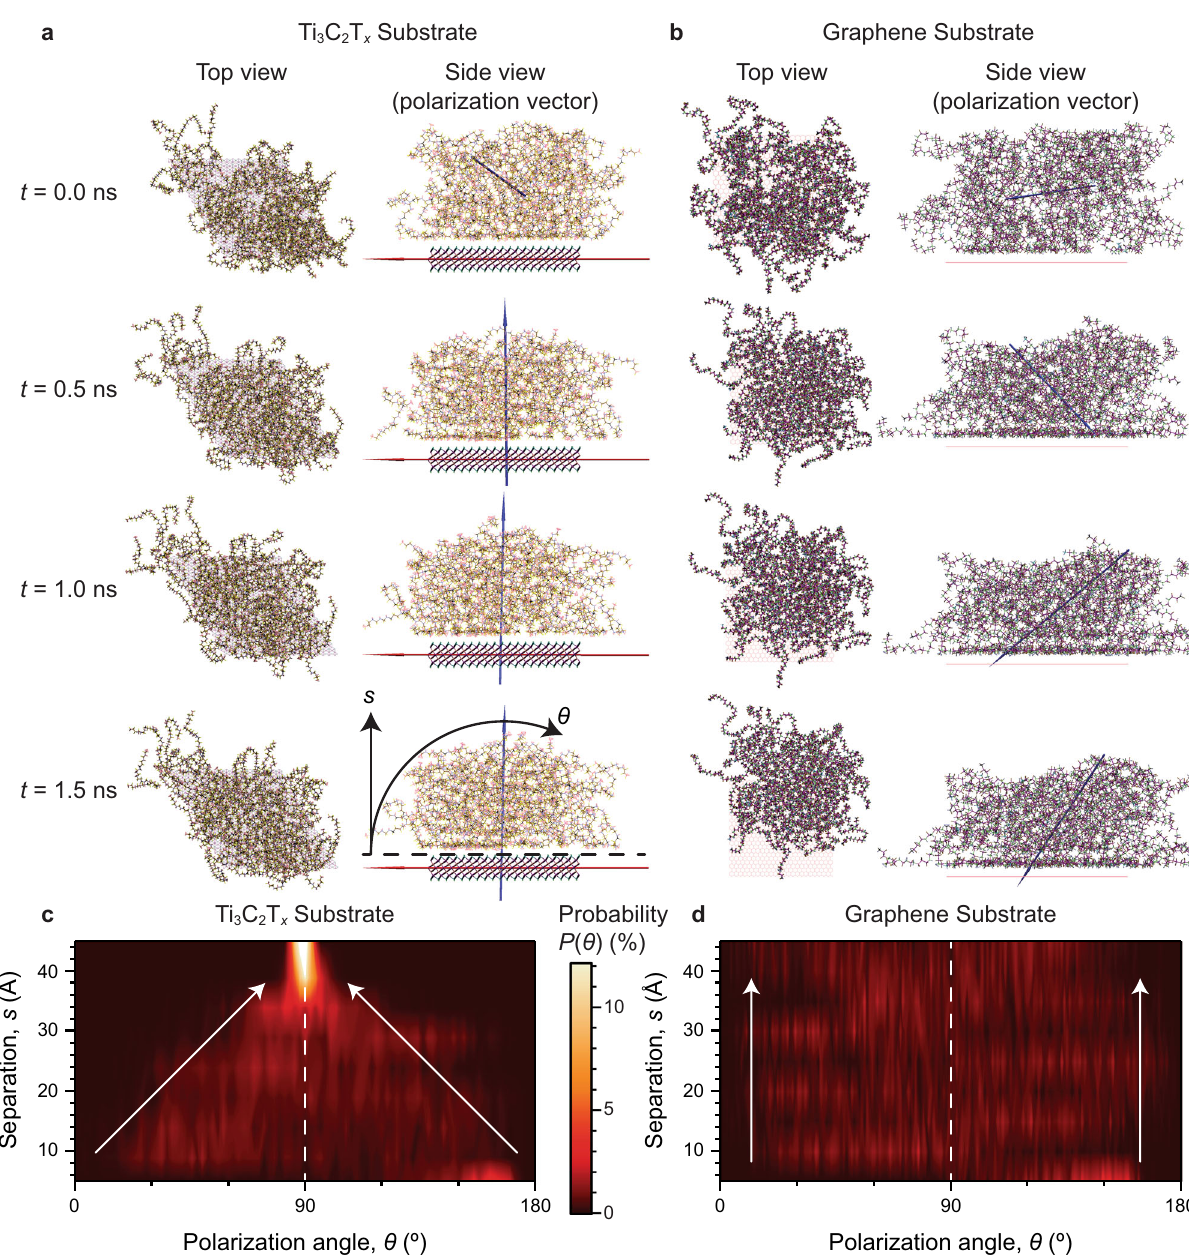
Fig. 2 Comparative MD simulations of the PVDF-TrFE co-polymer fi lm polarization on Ti 3 C 2 T x and graphene substrates. a , b The top view (left column) and side view (right column) snapshots at t = 0, 0.5, 1, and 1.5 ns, with the resultant polarization vectors (right column) of the PVDF-TrFE co-polymer fi lm (blue arrow) and a Ti 3 C 2 T x substrate (red arrow) or b graphene substrate. The annotated s and θ in a represent the separation of the fl uoropolymer from the substrate and the PVDF-TrFE co-polymer polarization angle relative to the substrate, respectively. c , d Probability distributions of the angle ( θ ) between the polarization vector of the PVDF-TrFE co-polymer fi lm layers and the c Ti 3 C 2 T x or d graphene substrates as a function of separation ( s ), as calculated from the equilibrated region of the obtained MD